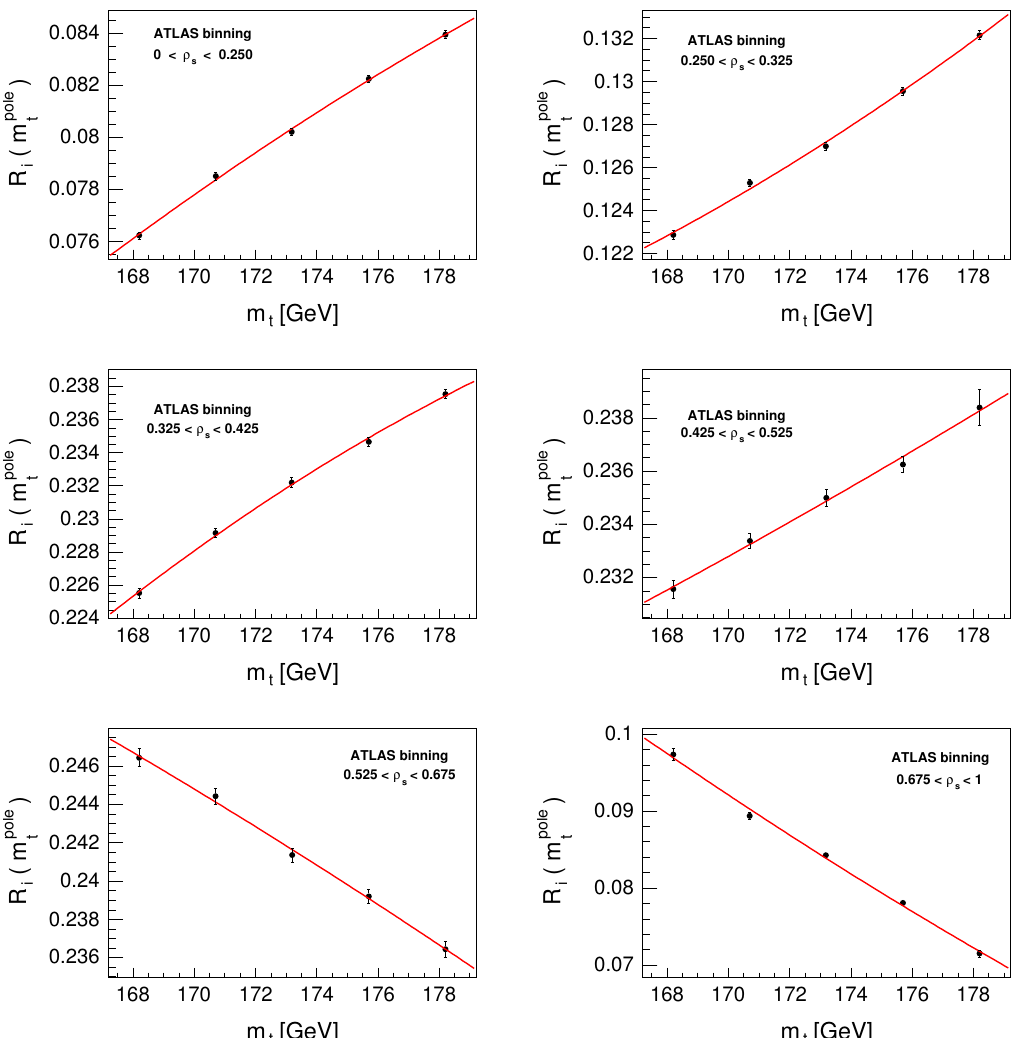
Figure 6 . Bin-by-bin (cid:12)t of template distributions for the normalised (cid:26) s observable as given by full theory at NLO in QCD for the pp e + (cid:23) e (cid:22) (cid:0) (cid:22) (cid:23) (cid:22) b (cid:22) bj + X production process at the LHC with ! p s = 13 TeV. The CT14 PDF set and (cid:22) R = (cid:22) F = (cid:22) 0 = H T = 2 are used. The ATLAS binning is assumed. The error bars denote statistical